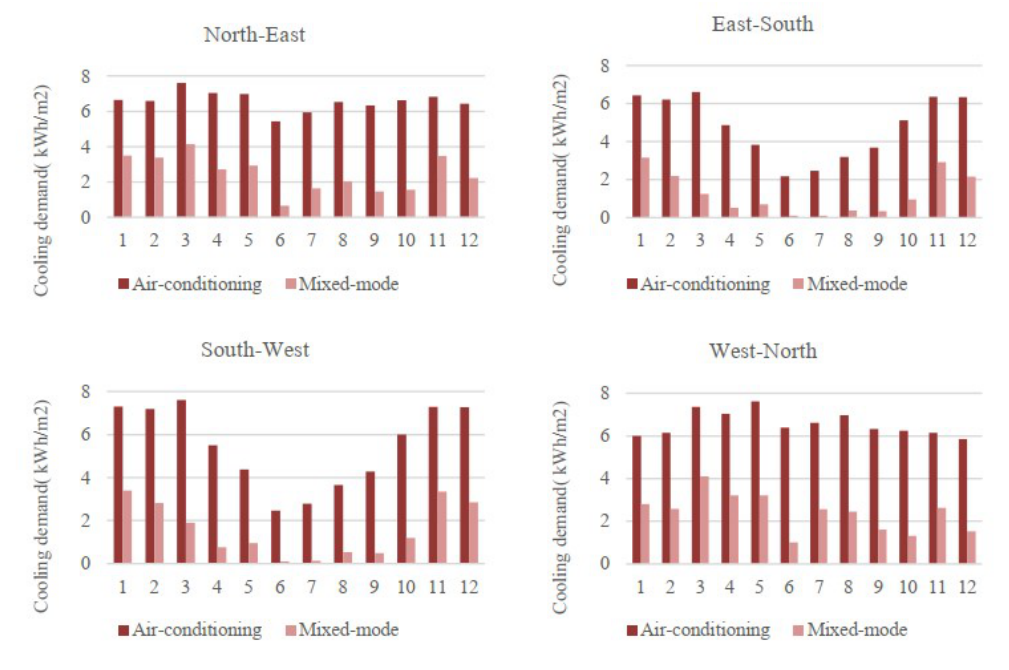
Figure 2. Energy demand for cooling – monthly results.